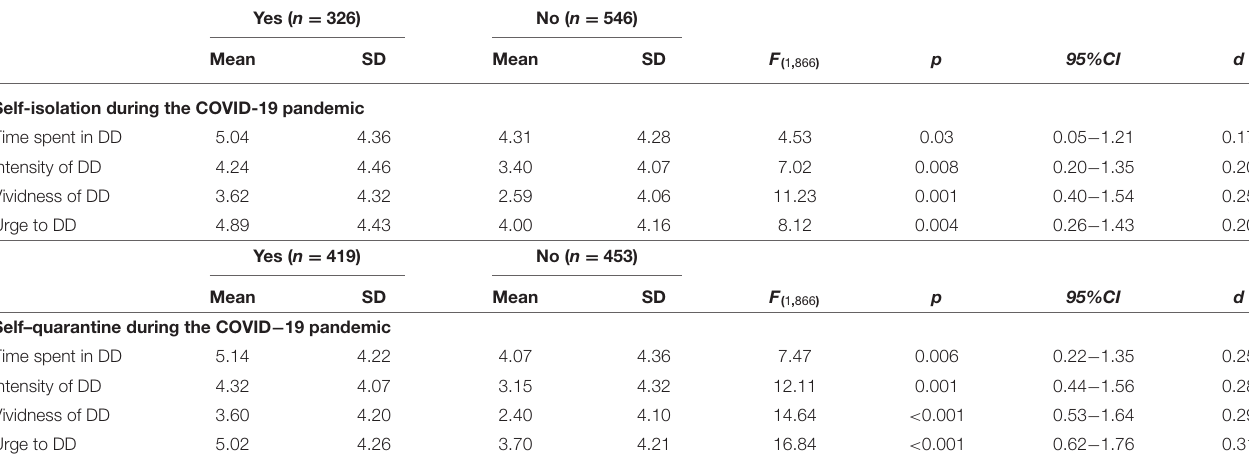
TABLE 1 | Post-hoc ANCOVA results of the relationships between self-isolation/quarantine and DD indices. Yes ( n =